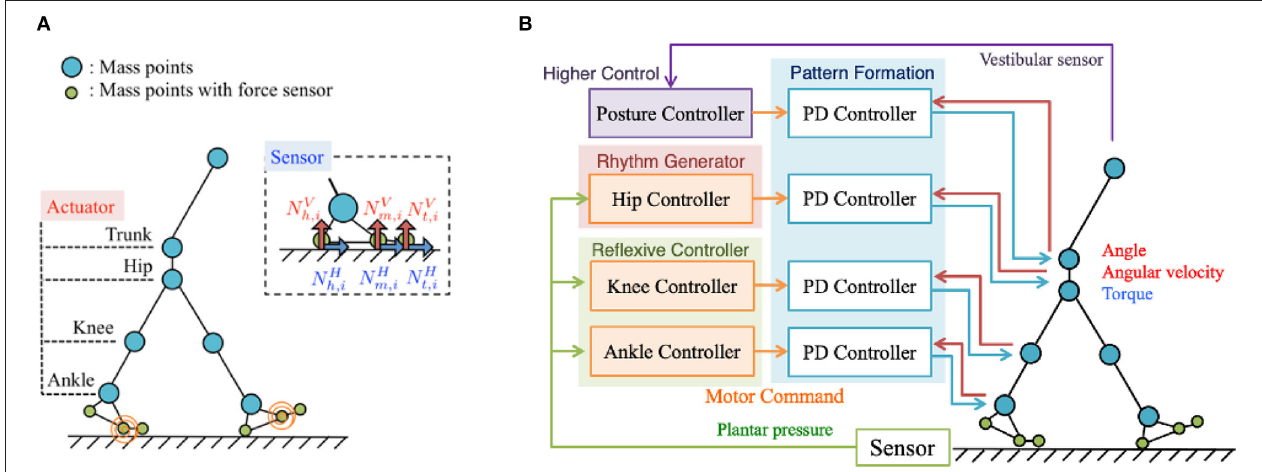
FIGURE 1 | (A) Musculoskeletal structure of the bipedal walking model. For simplicity and ease of modelling, the masses are located in the joints and movements constrained in the sagittal plane. The structure consists of 13 mass points (i.e., the trunk, waist, hip, knees, ankles, heels, metatarsals, and toes) and 14 rigid links that connect these mass points. The plantar sensation is modelled by incorporating sensors to detect the vertical and horizontal ground reaction forces (GRFs) ( N V x , i and N H x , i , respectively) exerted at heel ( x = h ), metatarsal ( x = m ), and toe ( x = t ) points on the feet. (B) Control system overview. The proposed control system for adaptive bipedal walking consists of four main components: (i) hip controllers, (ii) knee controllers, (iii) ankle controllers, and (iv) a posture